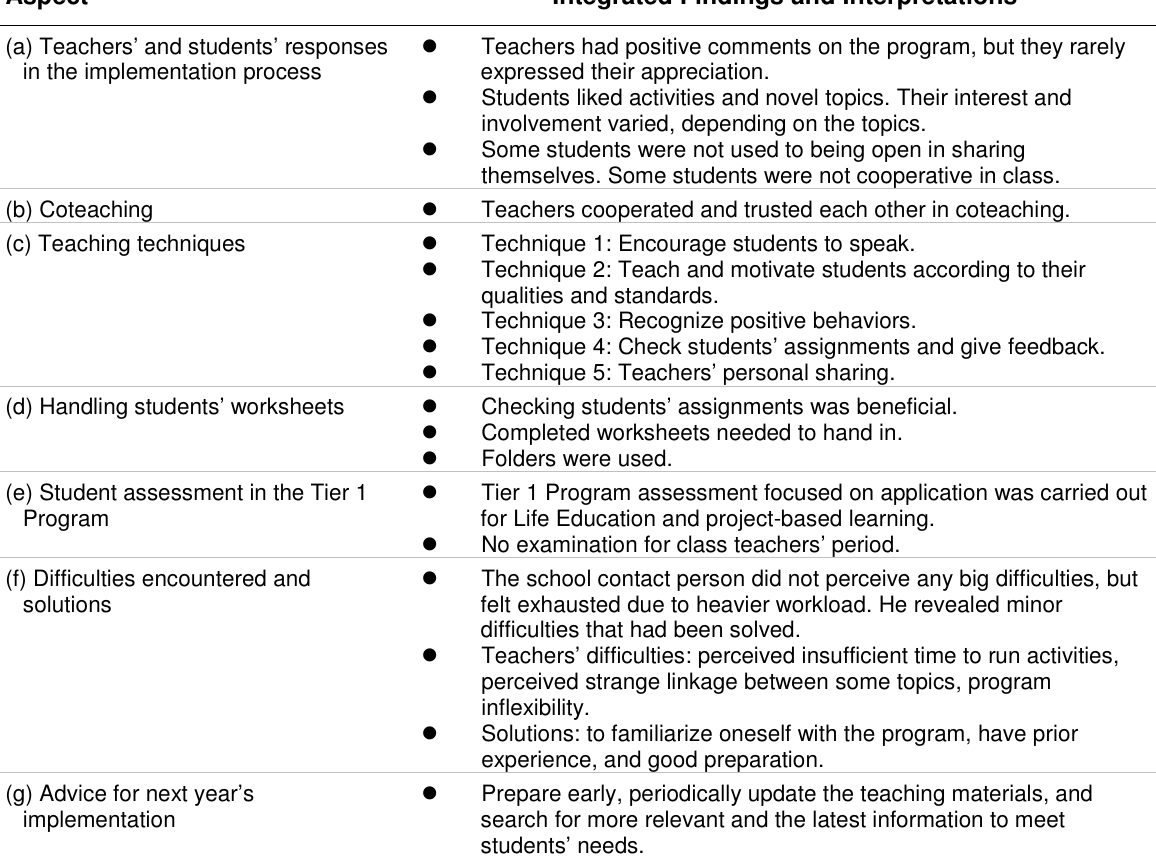
Consolidated Interpretations on the Implementation Characteristics in the School Integrated Findings and